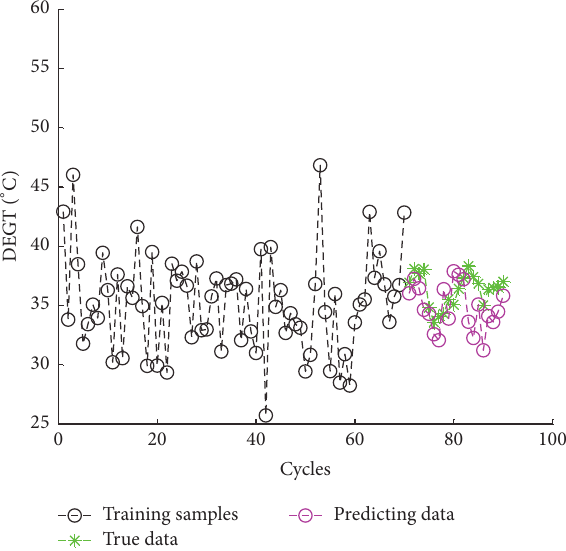
Figure 1: Prediction results of ANN with regularization. Figure 2: Prediction results of SVM with cross validation.